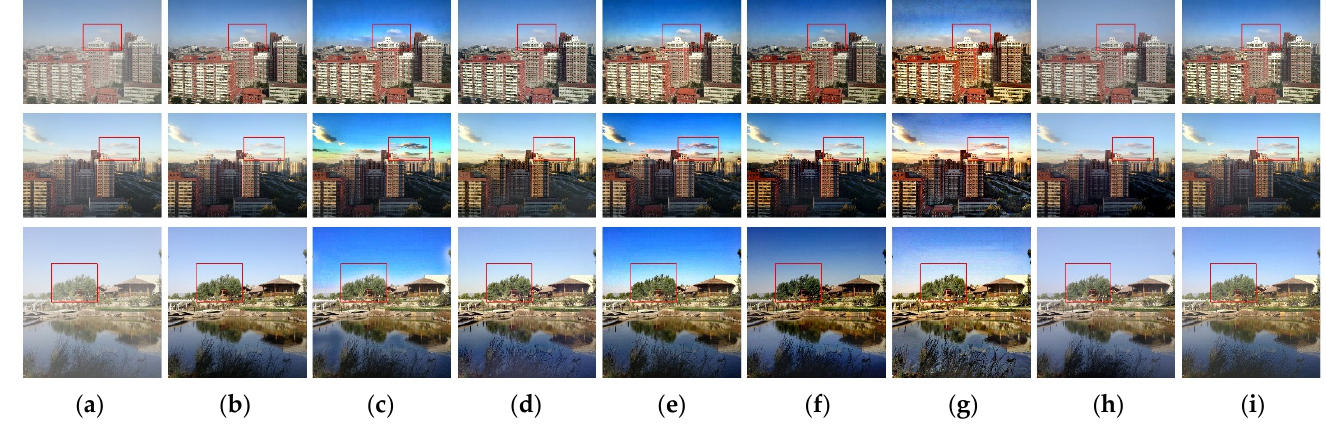
Figure 7. Comparison of the results of different dehazing methods for outdoor real images. ( a ) Input image, ( b ) fog-free image, ( c ) He method processing results, ( d ) Berman method processing results, ( e ) Dhara method processing results, ( f ) Choi method processing results, ( g ) Cho method processing results, ( h ) Cai method processing results, and ( i ) GIC method processing results.